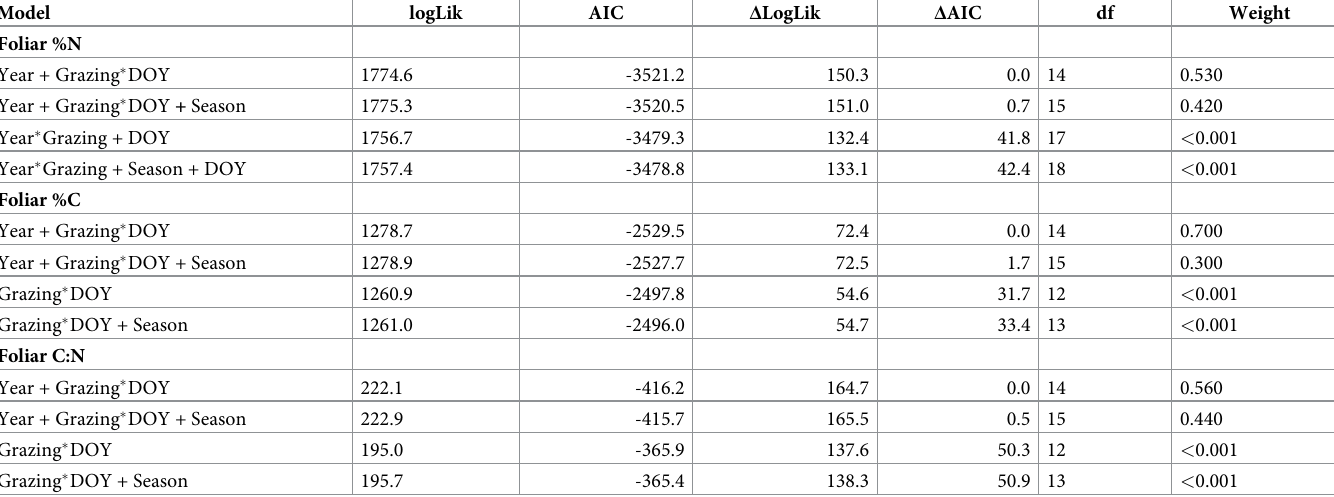
Table 2. Four top-performing models for foliage chemistry. Top models are based on AIC model selection for the treatment analysis over three years (2014–16). Abbre- viations: Grazing = Timing of grazing treatment, Season = Timing of season treatment, DOY = Day of year, Year = Year of experiment, AIC = Akaike information crite- rion, logLik = log likelihood, df = degrees of